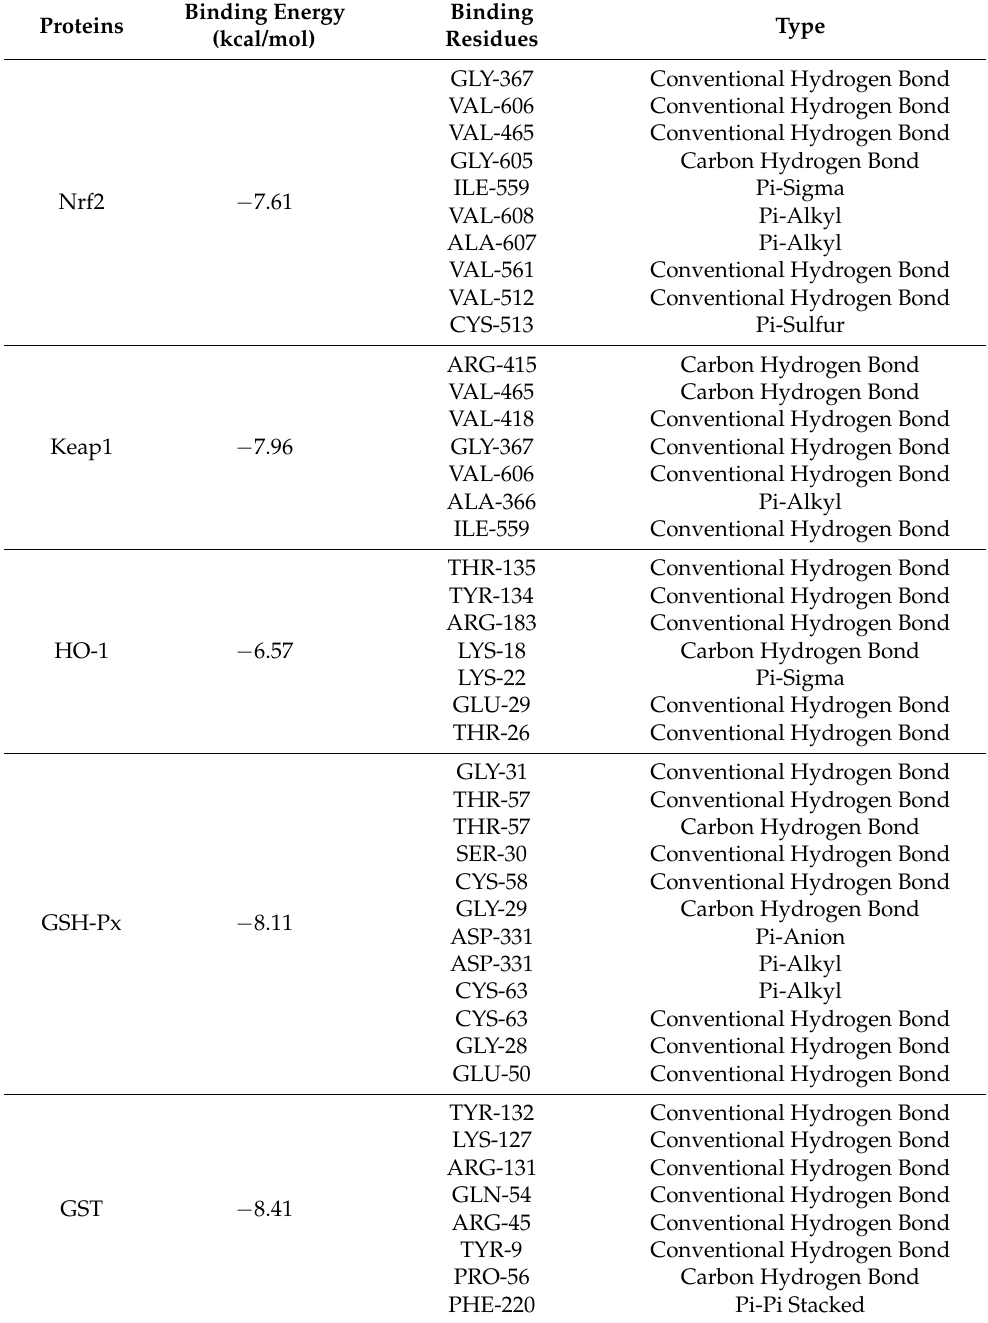
Table 4. Intermolecular interactions between rosmarinic acid and Nrf2, Keap1, HO-1, GSH-Px, and